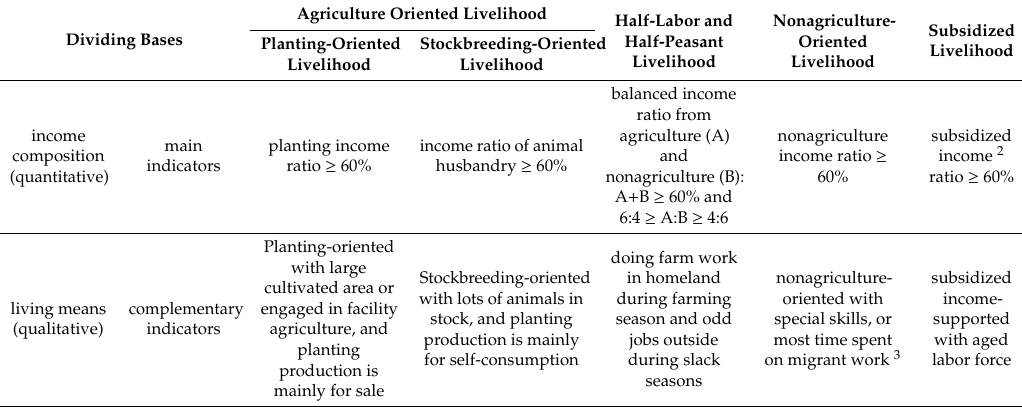
Table 1. Livelihood strategies in Jungar Banner.